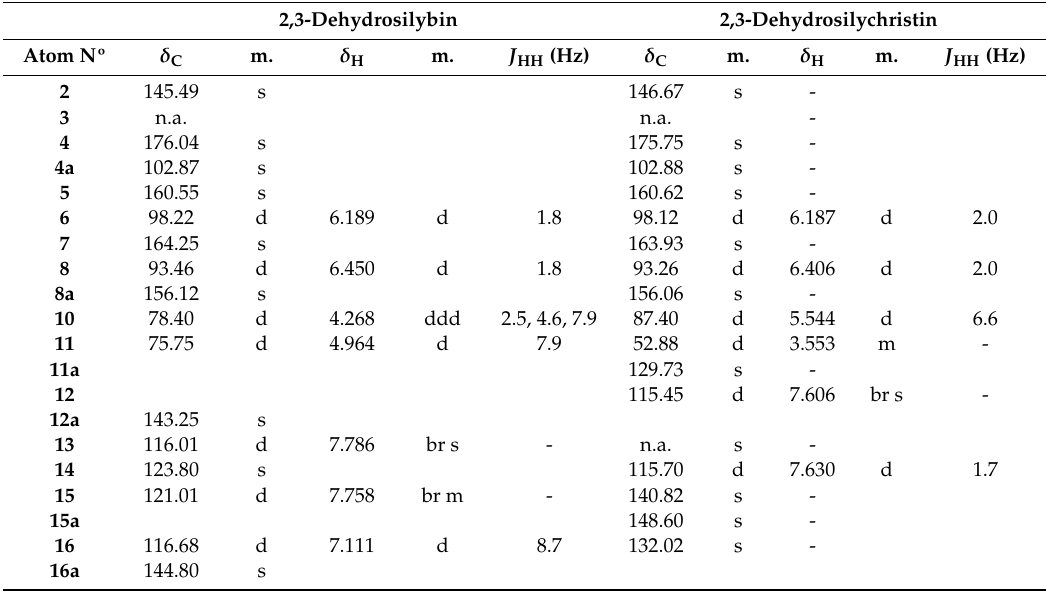
Table A1. 13 C and 1 H NMR data of 2,3-dehydrosilybin and